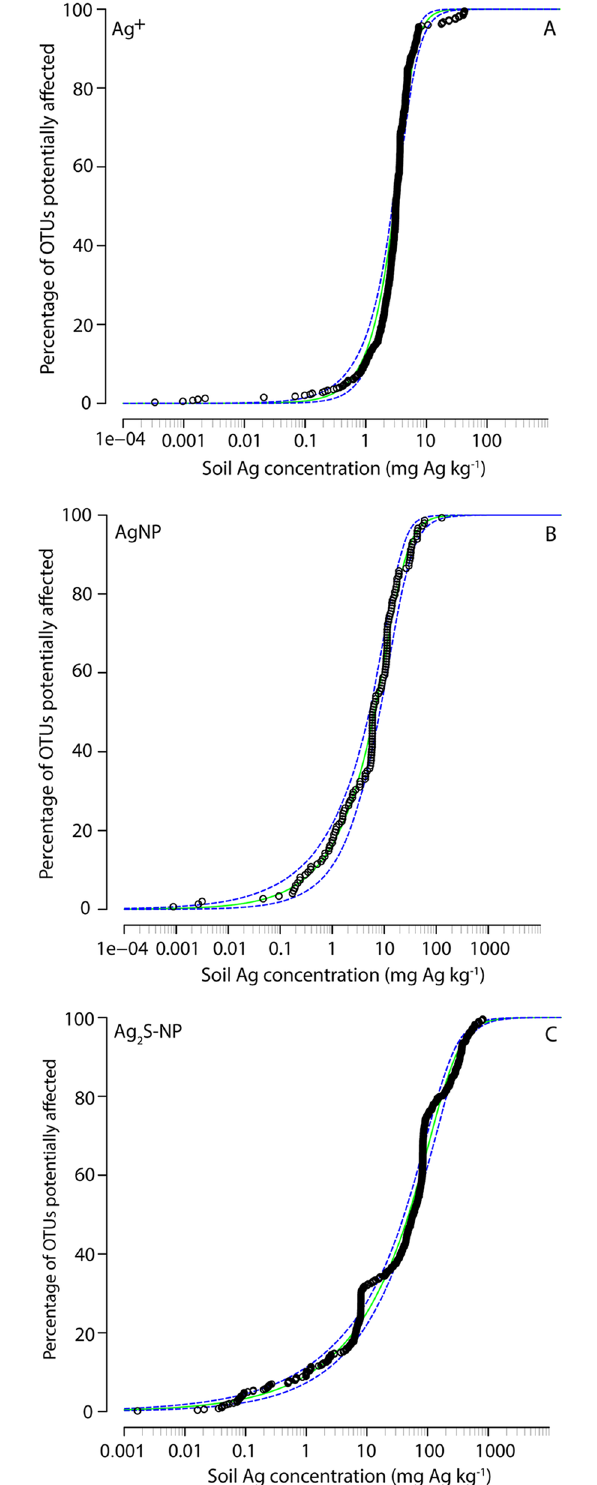
Fig 6. Operational taxonomic unit (OTU) sensitivity distributions (OSD) comparing the sensitivity of OTUs to each Ag treatment. Results are shown for each Ag treatment: (A) ionic Ag (Ag + ), (B) Ag nanoaparticles (AgNP) and (C) Ag sulfide nanoparticles (Ag 2 S-NP). Each data point corresponds to the